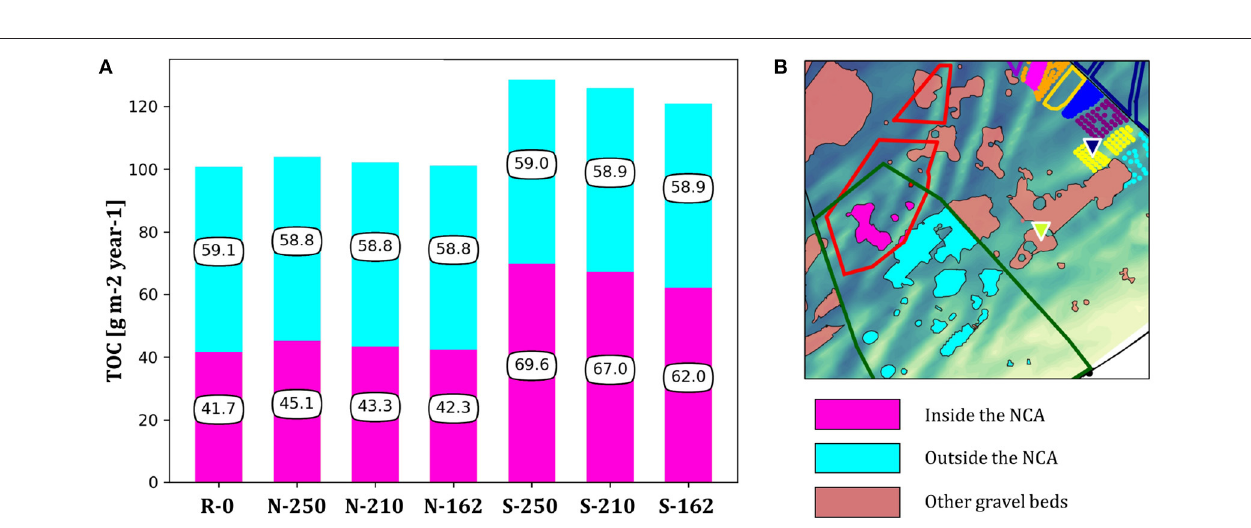
FIGURE 8 | (A) Annual TOC fluxes to the gravel beds, simulated under the scenarios of monopiles distribution defined for the NCA in Table 3 and for R-0 scenario. The TOC fluxes are spatially averaged over the gravel beds located inside (cyan) and outside (pink) the NCA. (B) Position of gravel beds inside the NCA and Natura 2000 (pink) and outside of the NCA but inside the Natura 2000